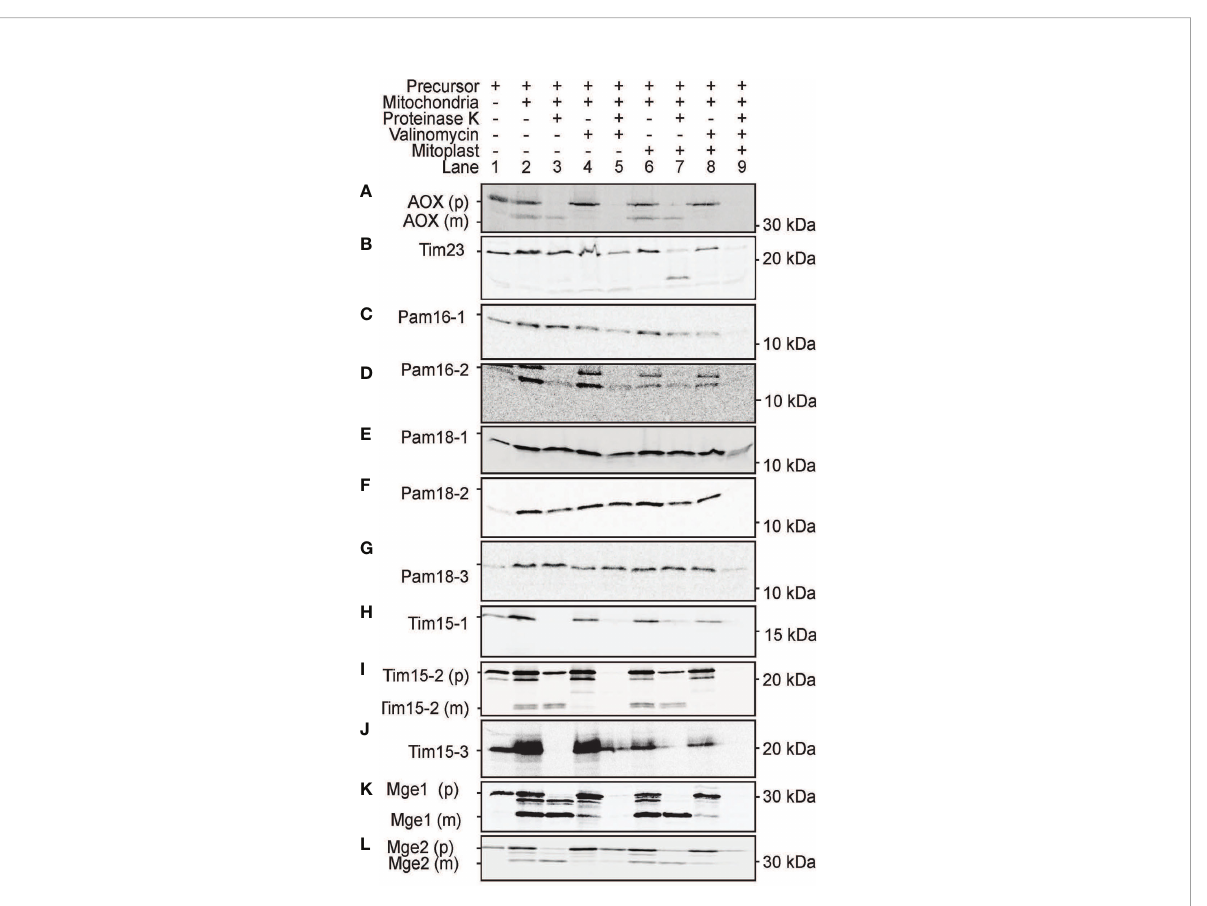
FIGURE 8 Protein import assays into isolated mitochondria. (A) Alternative Oxidase (AOX) was used as a control for successful import into the mitochondrial matrix while Tim23-2 (B) was used to test for the successful rupture of the outer membrane by osmotic shock following protein import. Pam16 (C, D) . Pam18 (E – G) . Tim15 (H – J) . Mge (K, L) . Lane 1 = precursor protein alone, lane 2 = precursor protein incubated with mitochondria under conditions that support import, lane 3 = as lane 2 with the addition of Proteinase K (PK) following import, lane 4 = same as lane 2 but with the addition of valinomycin prior to import, lane 5 = same as lane 4 but with the addition of PK following import, lane 6 = same as lane 2 but with outer membrane ruptured after import, lane 7 = same as lane 6 but with the addition of PK following import, lane 8 = same as lane 6 but with valinomycin prior to import, lane 9 = same as lane 8 but with PK treatment. (p) = precursor protein band. (i) = intermediate protein band. (m) = mature protein band. Position of protein size marker is shown on the